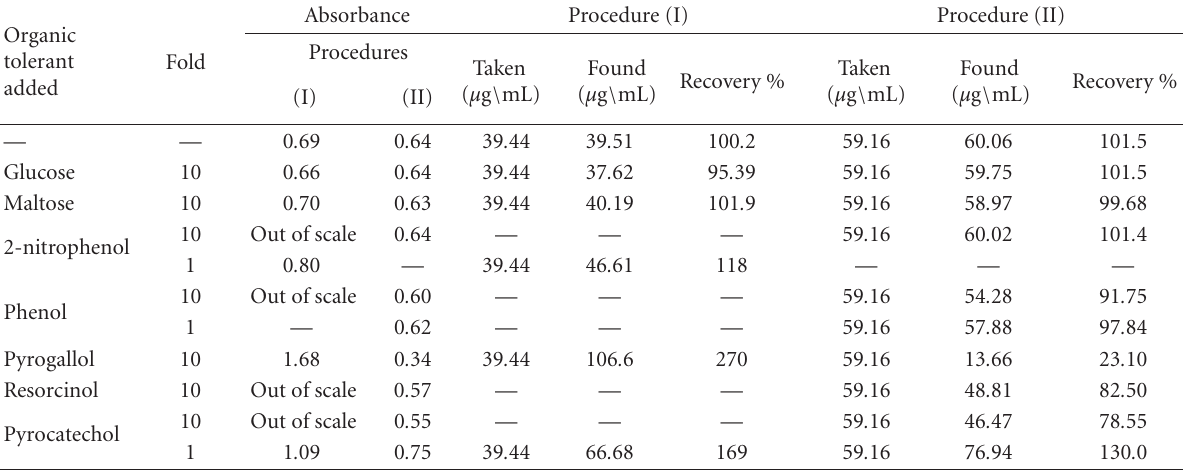
Table 2. Tolerance of organic compounds in spectrophotometric determination of LD. [LD] = 2 × 10 − 4 M, [Cu(II)] = 0 . 1M, [4-AAP] =